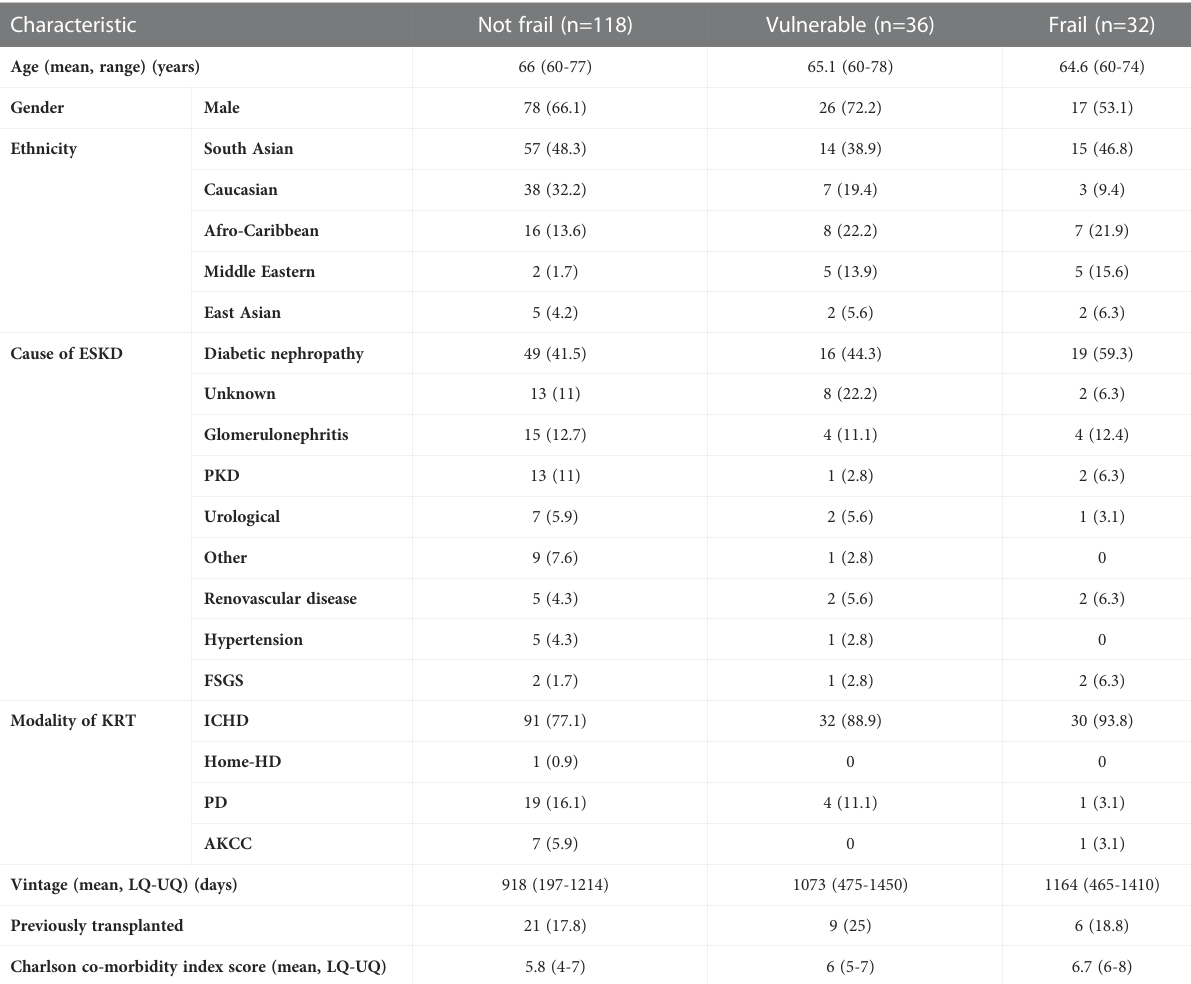
TABLE 2 Clinical demographics of study cohort by frailty status.